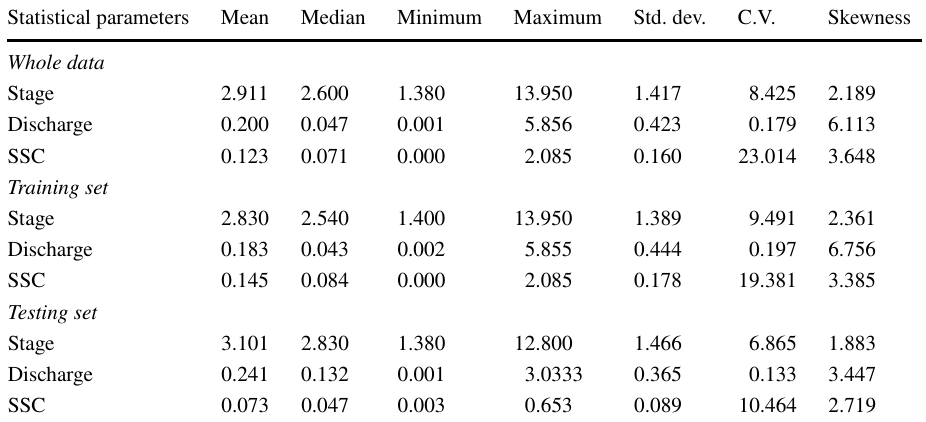
for all data, training data, and testing data of stage (m), discharge (m 3 /s), and SSC (g/l) for the Adityapur site